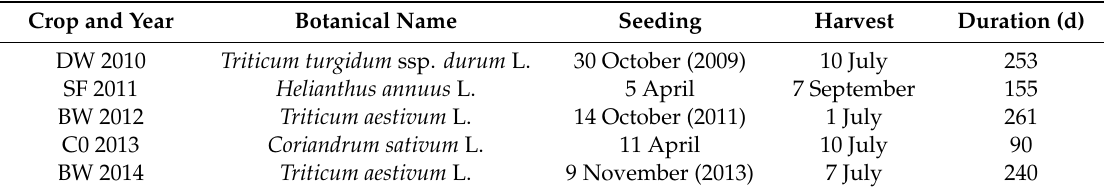
Table 1. Seeding and harvest dates, and crop cycle duration of cultivated